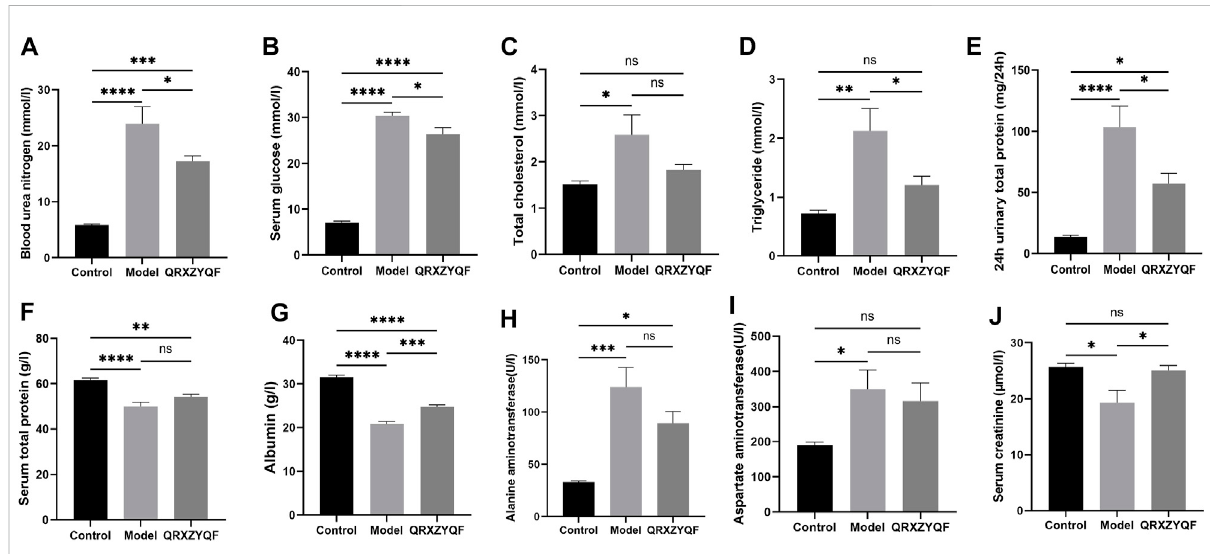
FIGURE 3 QRXZYQFtreatmentimprovedrenalfunctionandglycolipidmetabolicdisordersinDKDratsafter16 weeks( n =8,means±SEM). ns P > .05,* p < .05, ** p < .01, *** p < .001, **** p < .0001. (A) Blood urea nitrogen (BUN); (B) Serum glucose; (C) Total cholesterol (TC); (D) Triglyceride (TG); (E) 24 h urinary total protein (24 h-UTP); (F) Serum total protein (TP); (G) Albumin (Alb); (H) Alanine aminotransferase (ALT); (I) Aspartate aminotransferase (AST); (J) Serum creatinine